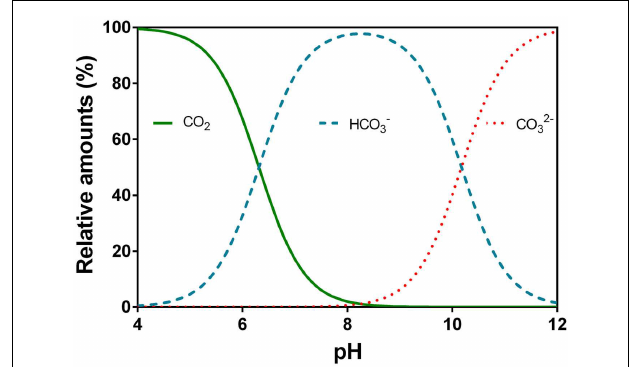
FIGURE 5 | Relative speciation (%) of carbon dioxide (CO 2 ), bicarbonate (HCO − ), and carbonate (CO 2 − ) in water as a function of pH. 3 3 The example given is at 20˚C and electrical conductivity of 250 µ S cm − 1 . Data were calculated using Gutz (2012) with the apparent p K 1 = 6.532 and p K 2 = 10.329 (Schwarzenbach and Meier,